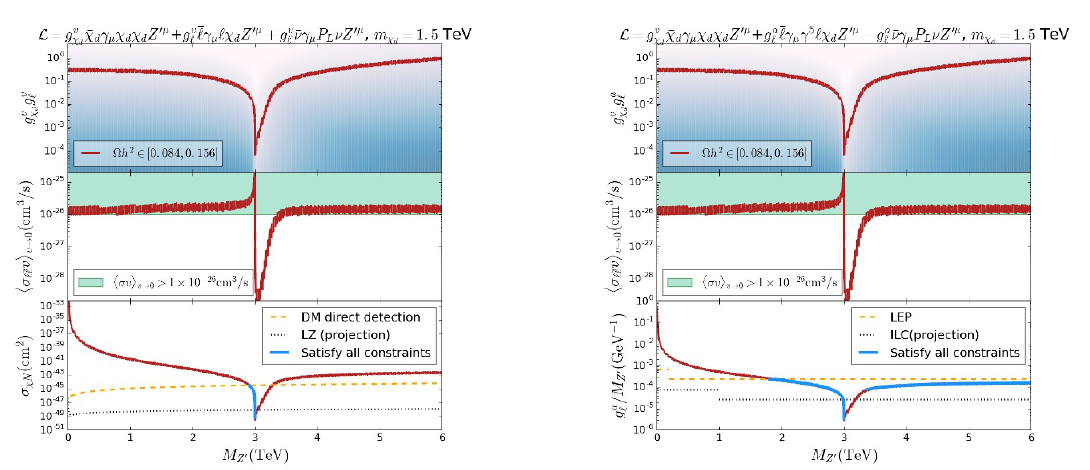
Figure 5 . A vector mediator vector coupled to complex (left) and axial-vector (right) coupled to leptons and neutrinos simultaneously. Each panel shows DM properties as a function of mediator mass. The blue color gradient in the (cid:12)rst panel shows relic density, where darker blue means greater relic